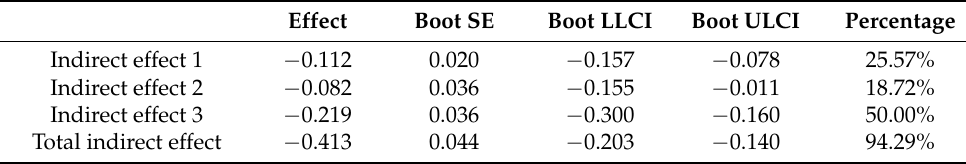
Table 3. Results of chain-mediated effect